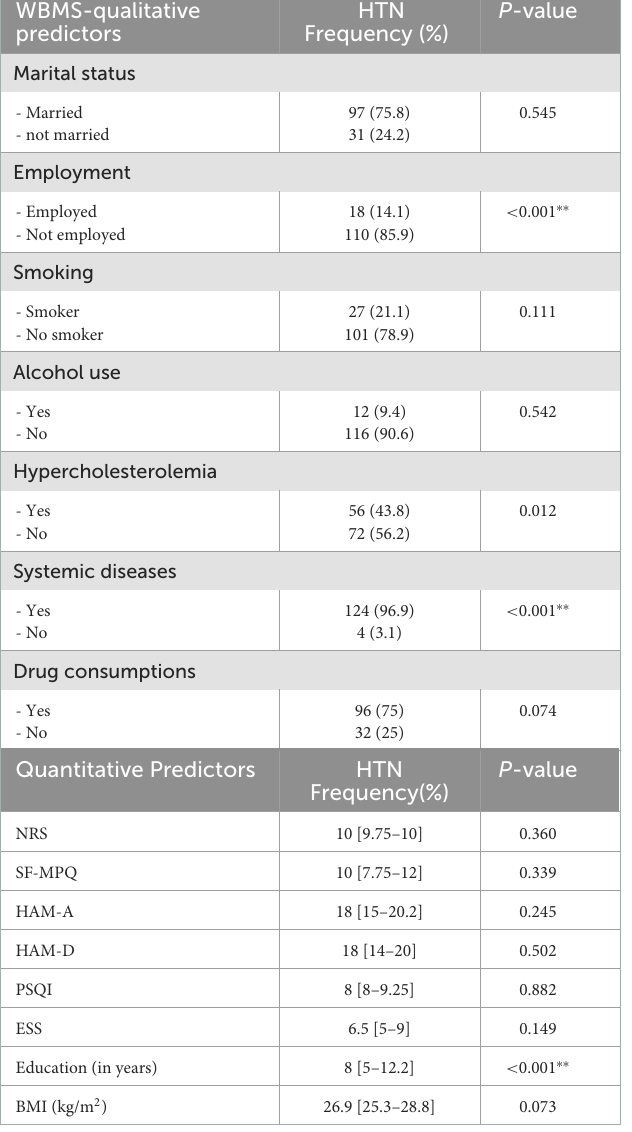
TABLE 5 Dependence analysis among 128 WBMS patients with HTN and qualitative and quantitative predictors. WBMS-qualitative predictors